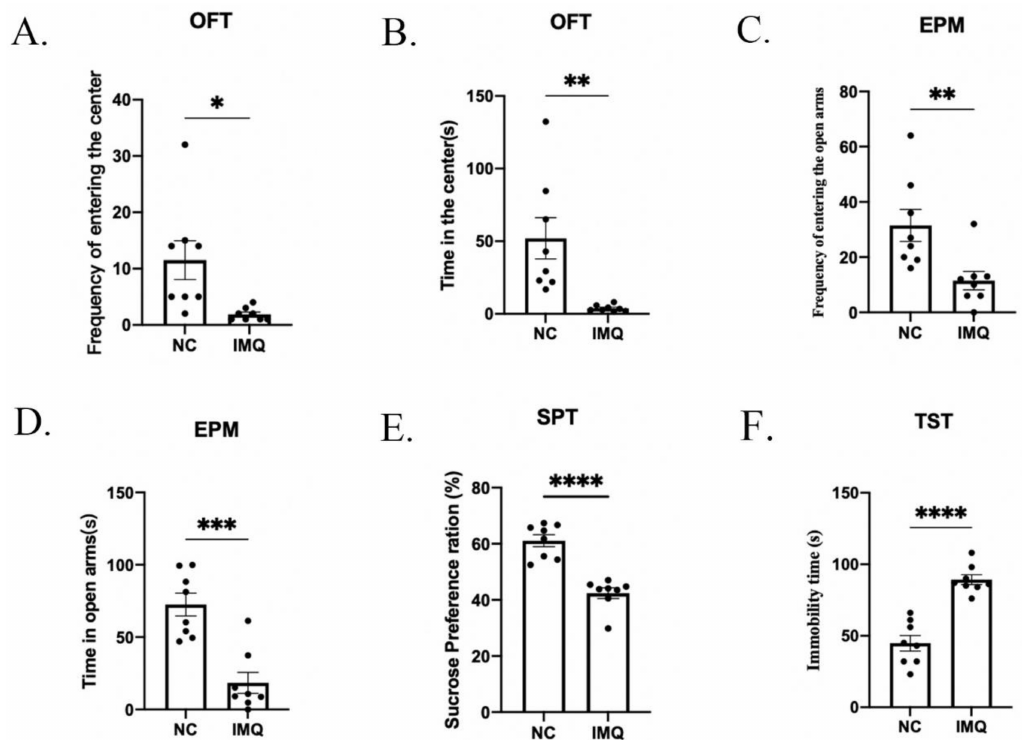
Figure 3. Behavioral deficits in IMQ induced psoriasis-like female mice without experiencing MS. ( A ) The frequencies of entering the center; ( B ) time in the center in the OFT. ( C ) The frequencies of entering the center; ( D ) time in the open arms in the EPM. ( E ) The sucrose preference ratio in the SPT. ( F ) Immobility time in the TST. Each value represents the mean ± SEM. n = 8 animals per group. Two groups (NC, IMQ) were analyzed using t -test (* p < 0.05, ** p < 0.01, *** p < 0.001 and **** p < 0.0001).